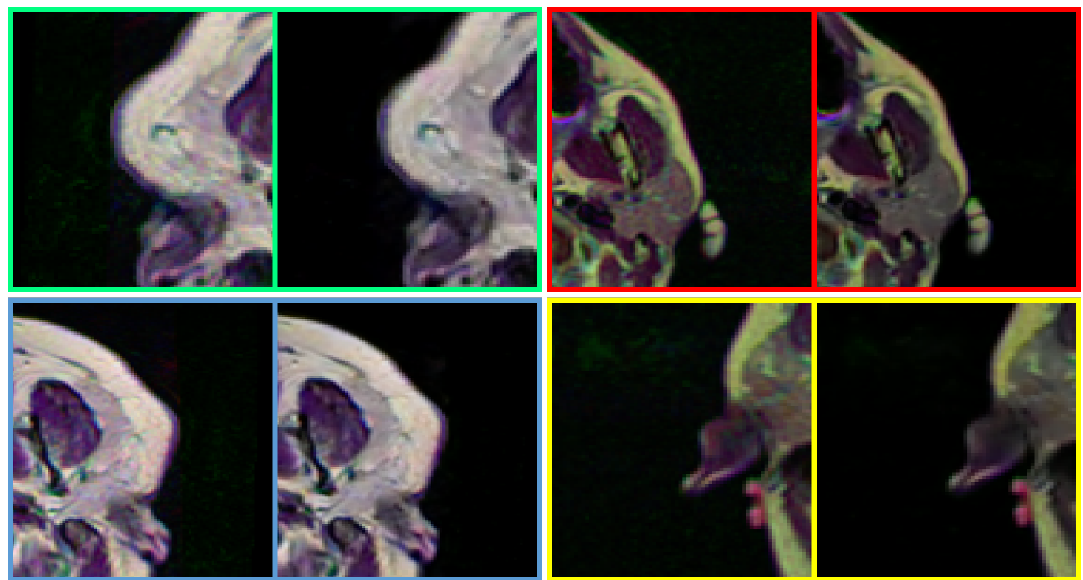
Figure 8. Performance of the proposed method in removing noise from real-world medical images. The proposed method can handle real-world noise without producing any visually disturbing artefacts. In each pair, left: Noisy input, Right: Denoised image (obtained by DRAN). Source by: (https://www.